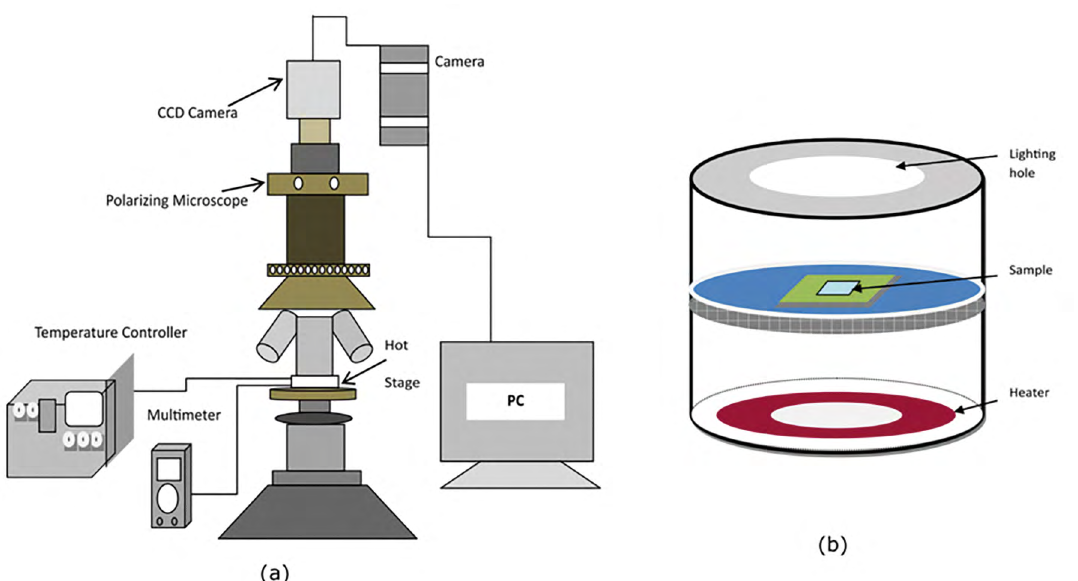
Figure 2. Experimental set-up to observe the spontaneous shape change as a function of temperature; the device consisted of a polarizing microscope, CCD camera, temperature controller, multimeter, hot stage, and PC (a). A glass containing the specimen was placed on the hot stage (b) 27 .